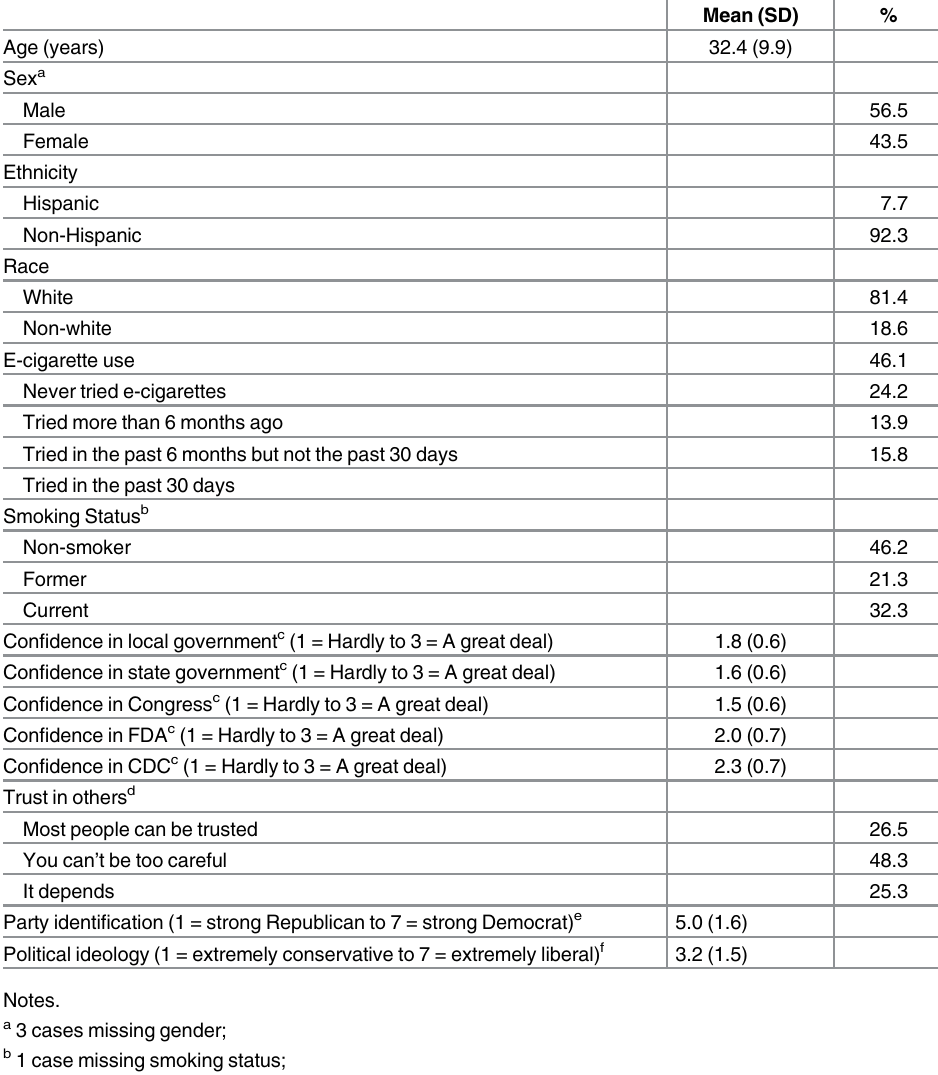
Table 1. Sample Characteristics (N =